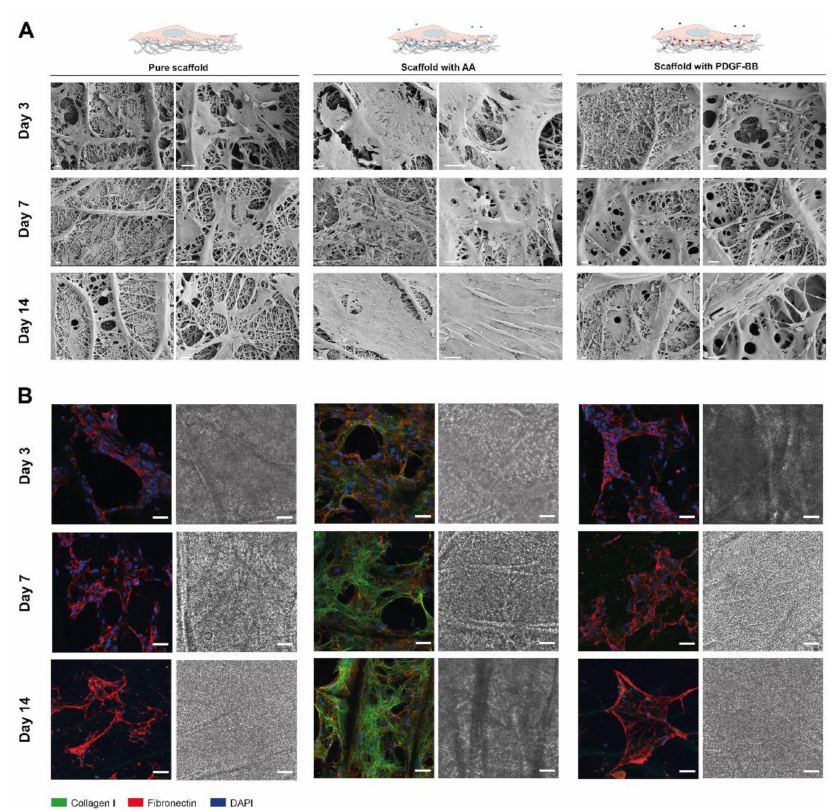
Figure 5. Tenocytes cultured on pure and bioactive sca ff olds over a period of 14 days. ( A ) SEM images of tenocytes, seeded on bioactive electrospun DP sca ff olds, containing either AA, PDGF-BB (bioactive sca ff olds) or none of them (pure sca ff old). The cell morphology and ECM deposition overtime is observed on the SEM images. ( B ) Representative CLSM images of collagen I (green), fibronectin staining (red) and cell nuclei DAPI staining (blue) of rabbit tenocytes cultured onto the electrospun sca ff olds. Scale bars: ( A ) 20 µ m and ( B ) 50 µ